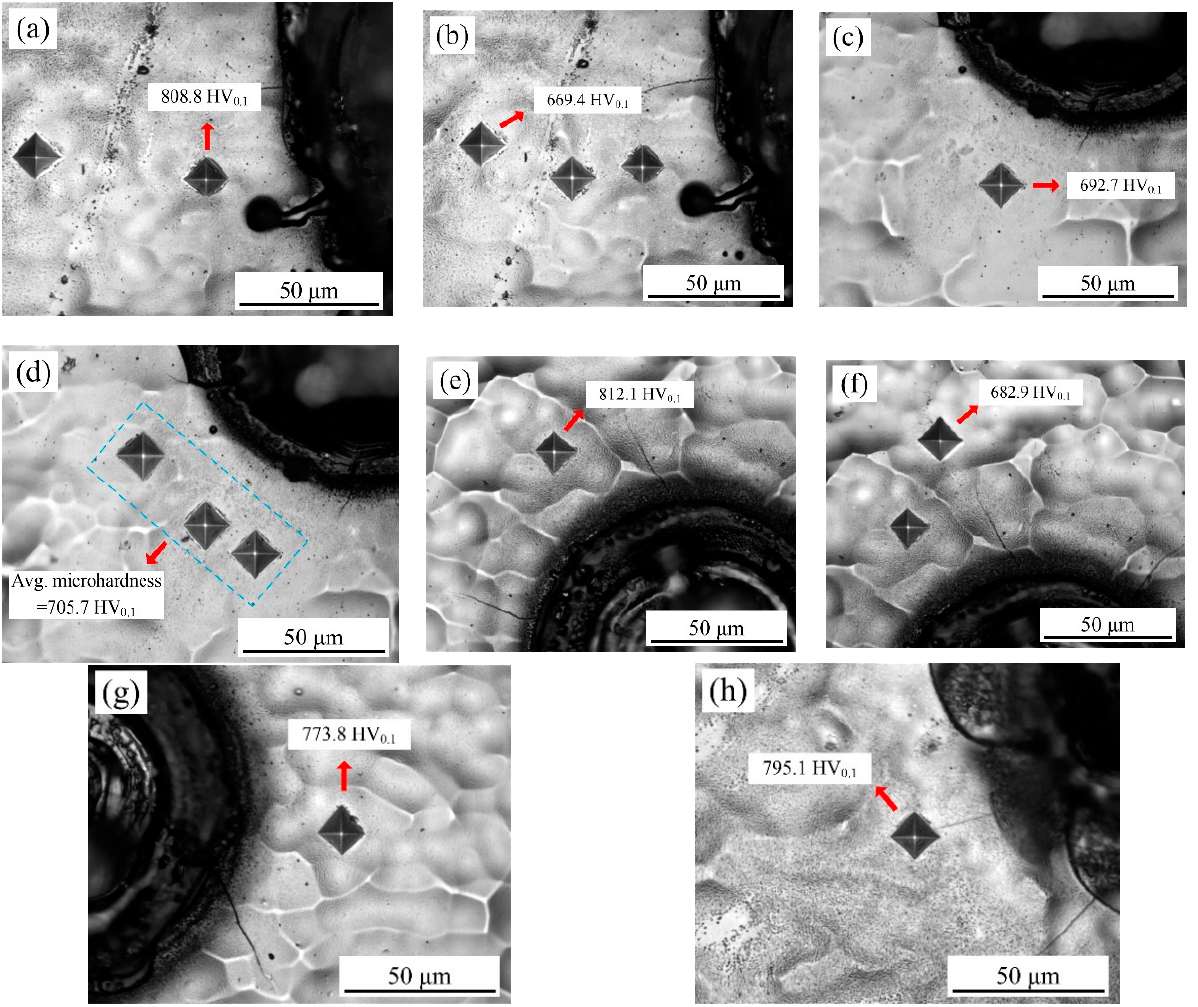
Figure 19. Optical microscopy images of the Vickers indent: ( a , b ) P = 50 W, τ = 50 µs; ( c , d ) P = 120 W, τ = 50 µs; ( e , f ) τ = 100 µs, P = 50 W; ( g ) τ = 75 µs, P = 50 W; ( h ) τ = 125 µs, P = 50 W.